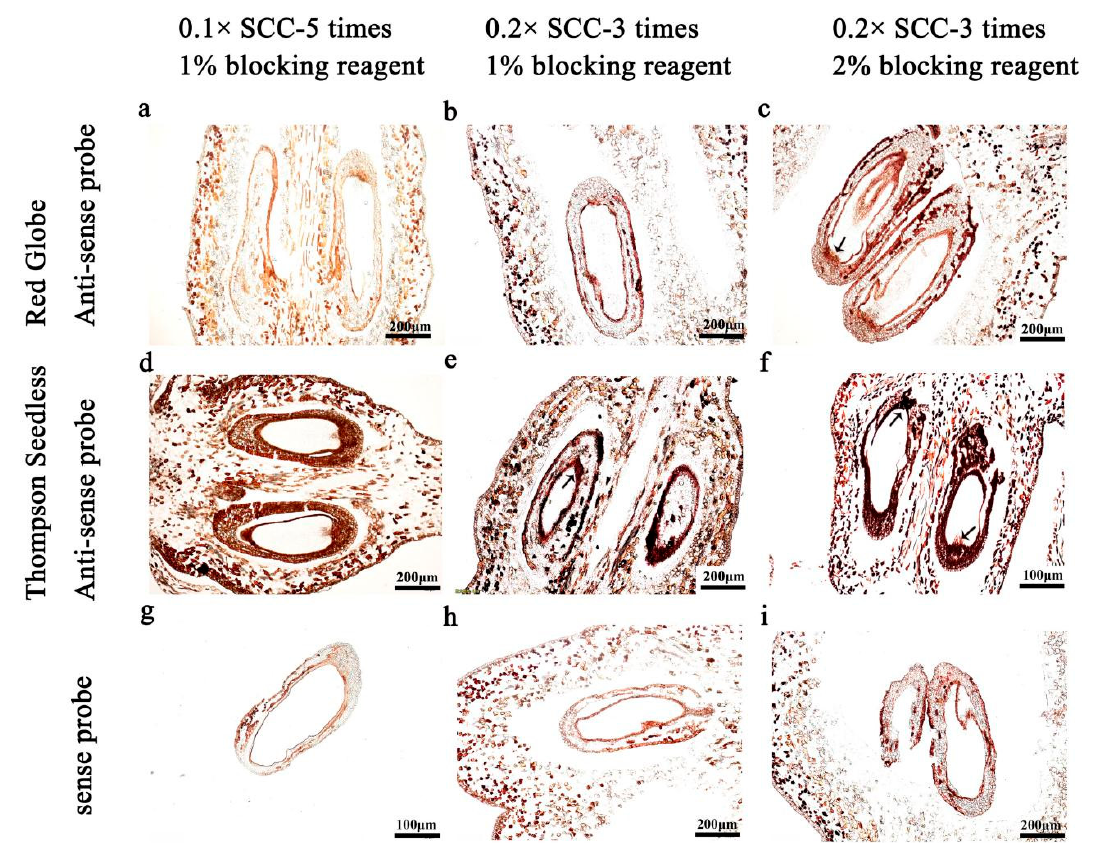
Figure 5. Optimisation of solution washing conditions after hybridisation. Three different washing conditions were improved by in situ hybridization, including five serial washes with 0.1 × SSC solution and blocking with 1% blocking solution for 45 min ( a , d , g ), three washes with 0.2 × SSC and sealing with 1% blocking solution for 45 min ( b , e , h ) and three washes with 0.2× SSC and sealing with 1% blocking solution for 45 min ( c , f , i ). ( a – c ): antisense probe, 10 DAF in ‘Red Globe’; ( d , f ): antisense probe, 10 DAF in ‘Thompson Seedless’; ( g – i ): sense probe. DAF: days after flowering. The ISH signal is evidenced by purple staining and indicated by a black arrow.